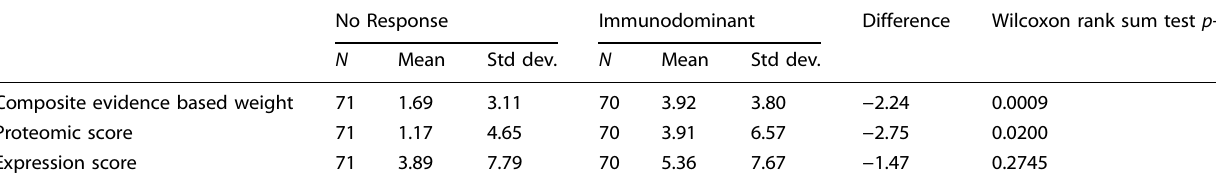
Table 1. Association of peptide library gene selection method with CD8 antigenicity